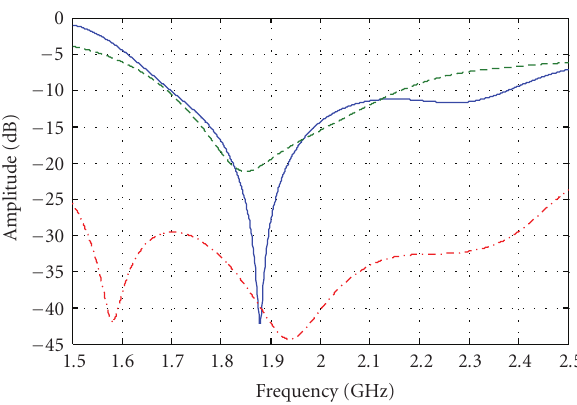
Figure 8: S -parameters for the Design 2.